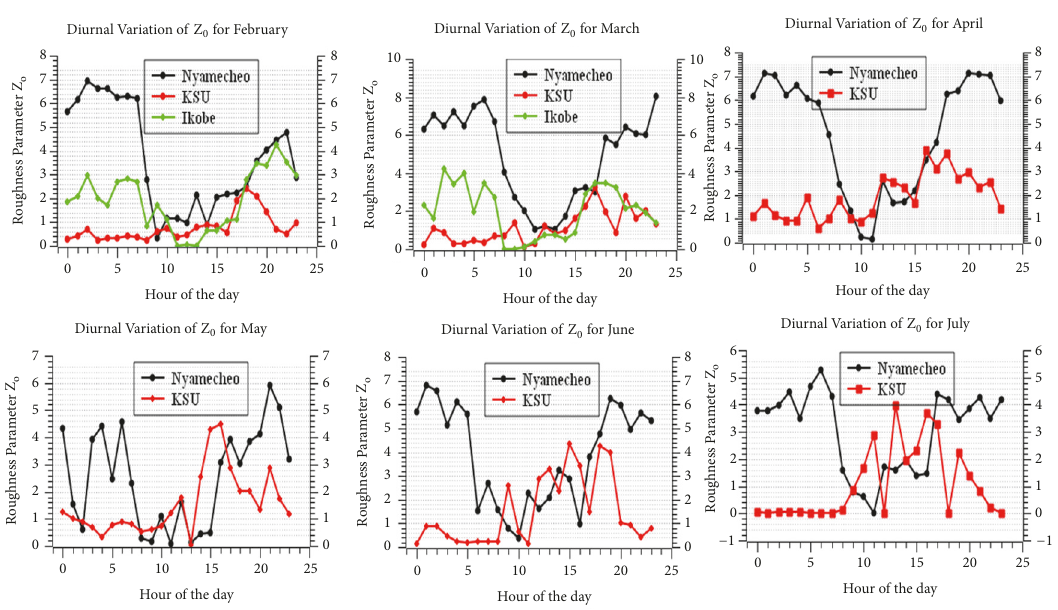
Figure 6: Diurnal variation of surface roughness parameter ( 𝑍 𝑜 ) at the selected sites for the six